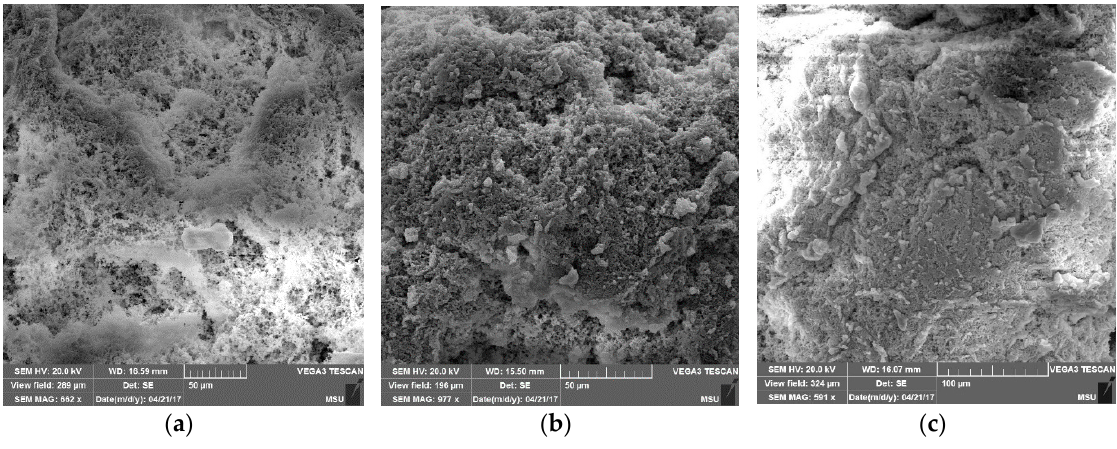
Figure 5. SEM images of the surface morphology of PE powders obtained from the catalytic system I for 10 min ( a ), 15 min ( b ), and 30 min ( c ).